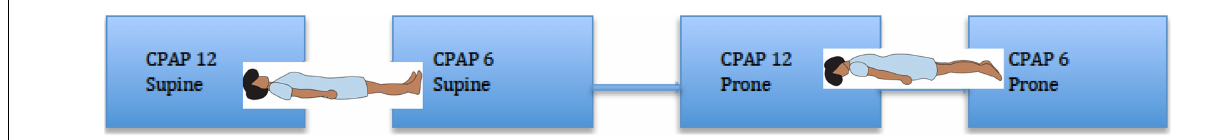
FIGURE 1 | Study steps protocol.